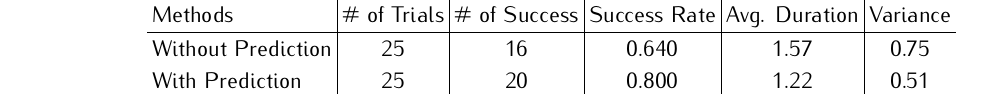
Table 3. Docking trials by reinforcement learning with and without prediction